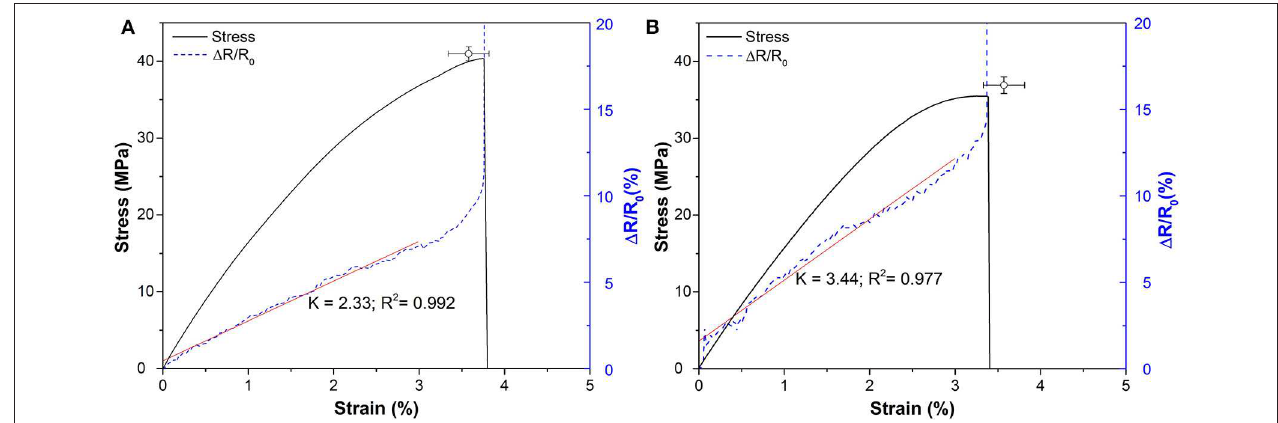
FIGURE 5 | Representative stress/strain curve and correspondent electrical resistivity change ( 1 R/R 0 ) of 3D-printed ABS/CNT nanocomposites under applied strain up to fracture: HC (A) and H45 (B) . Symbol indicates the average stress-strain at break of the three tested specimens. Gauge Factor is determined by the slope of the best fitting